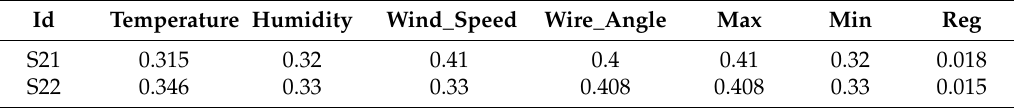
Table 5. S 2 .TB-qdatas